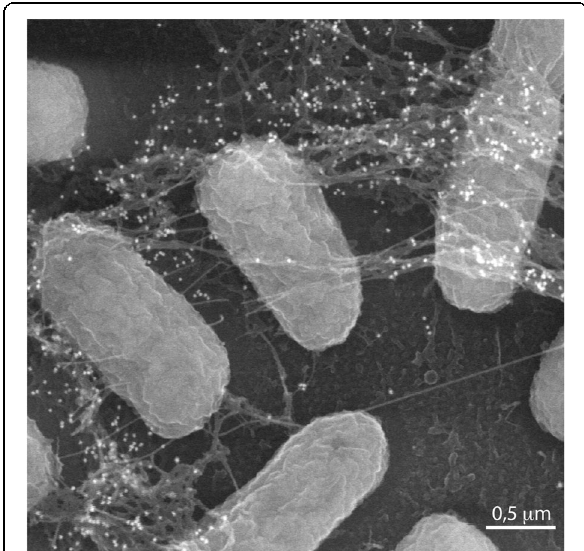
Fig. 1 Scanning electron microscopy of cellulose producing strain E. coli 1094. E. coli 1094. Bacteria with cellulose labeled by CBM29 – 1-2 and immunogold antibodies. Scanning electron microscopy and immunogold labelling were performed at LBCME facility, Faculte